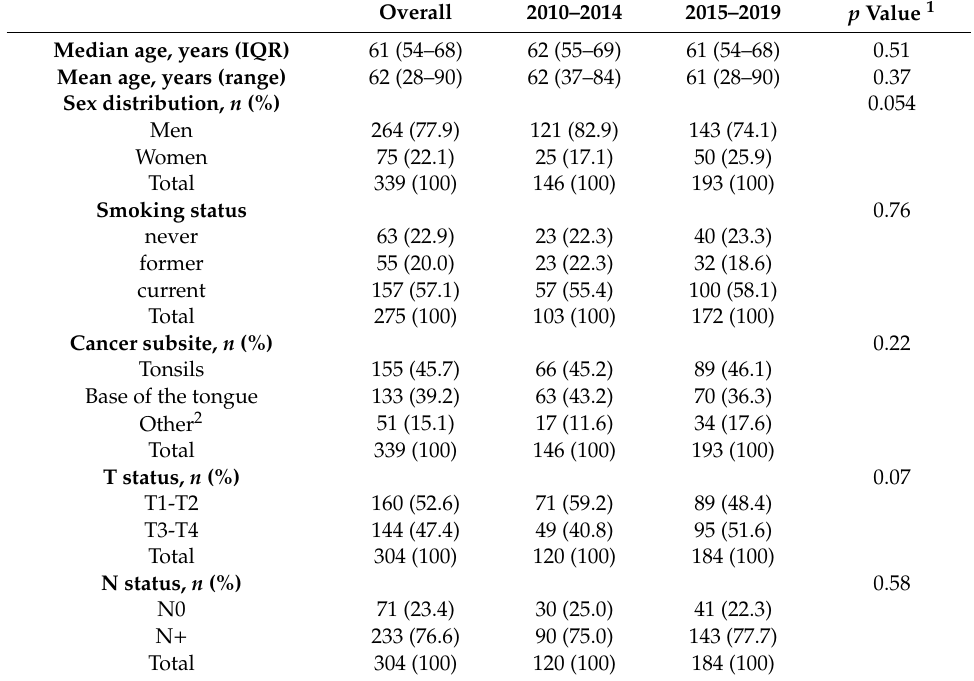
Table 1. Demographic and clinico-pathologic characteristics of the oropharyngeal squamous cell carcinomas (OPSCC) of the study population overall and according to the period of diagnosis.